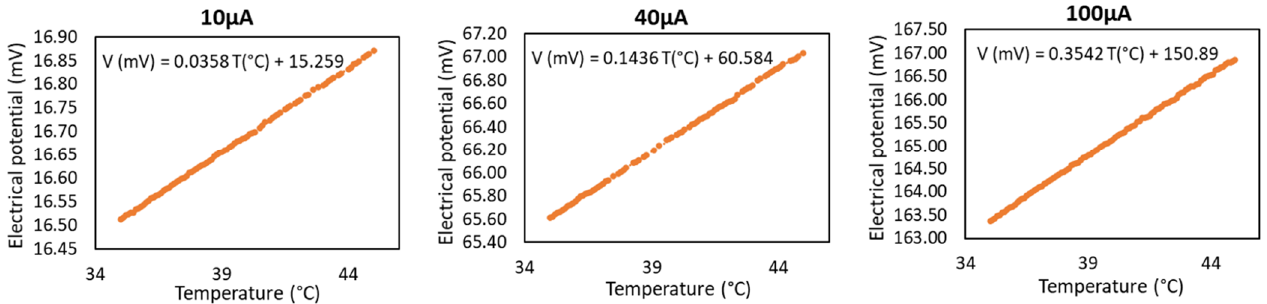
Figure 9. Experimental characterization of the microsensor with 24 windings using different excitation currents.